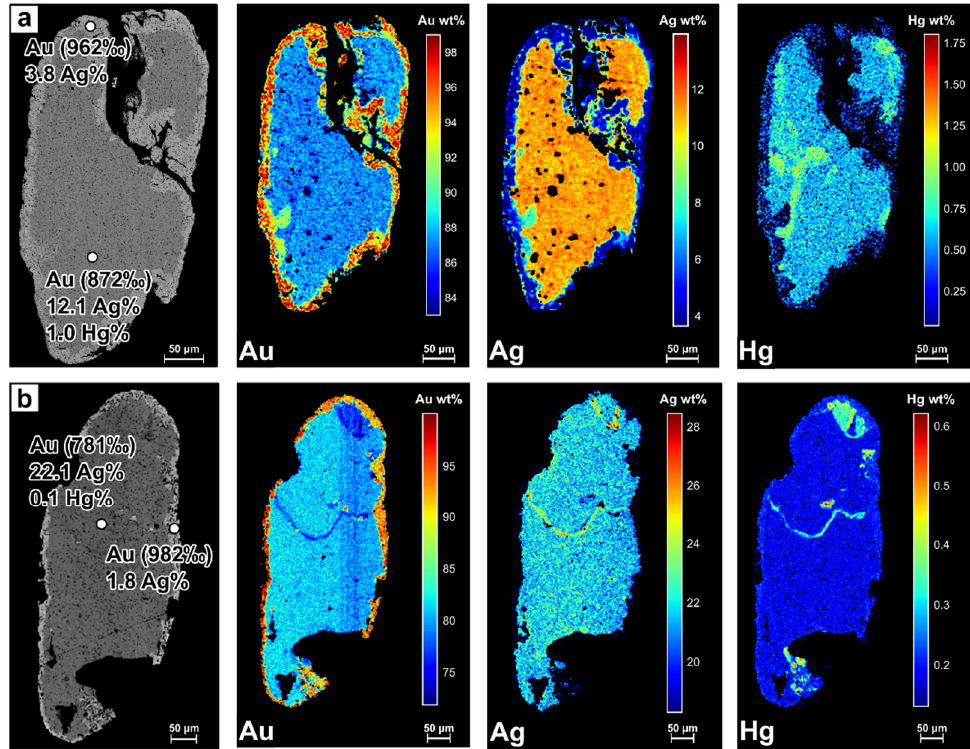
Figure 6. BSE image and EMPA chemical maps for Au-Ag-Hg. Colorscale in chemical maps shows the relative element abundance. Composition and native gold fineness in both core and rim of particle are shown. ( a ) Rim zonation that exhibits Ag-Hg depleted and Au enriched domains toward the edges. There is a sharp contact between the rim and the core. Hg contents seems to be less associated with Au-Ag contents in the particle core ( b ) Particle showing a compositional heterogeneity in the form of a ‘vein-like’ zone with higher contents of Ag and Hg. In both particles, Hg is absent in particle rims.